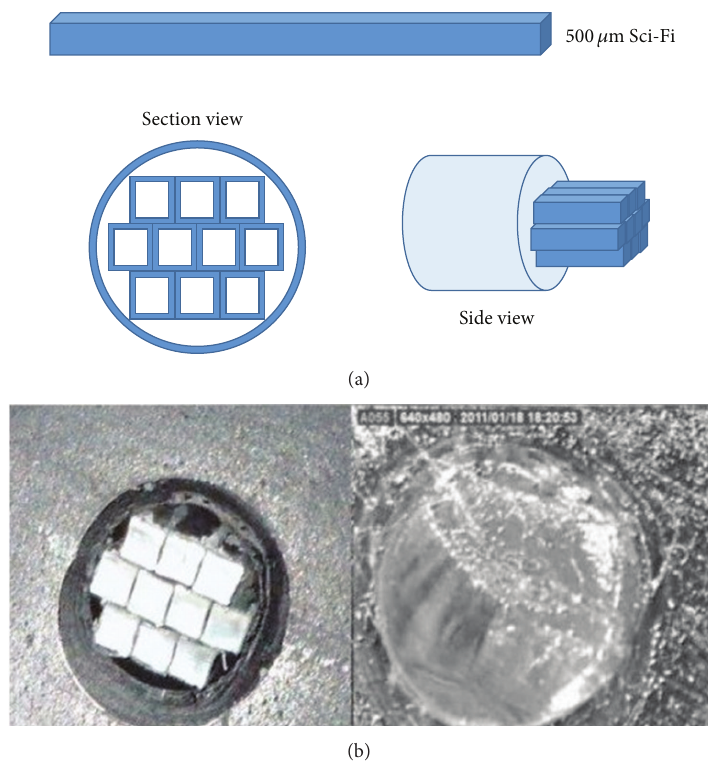
Figure 3: (a) The optical coupling scheme and (b) photographs of the Sci-Fi and clear fiber prepared for